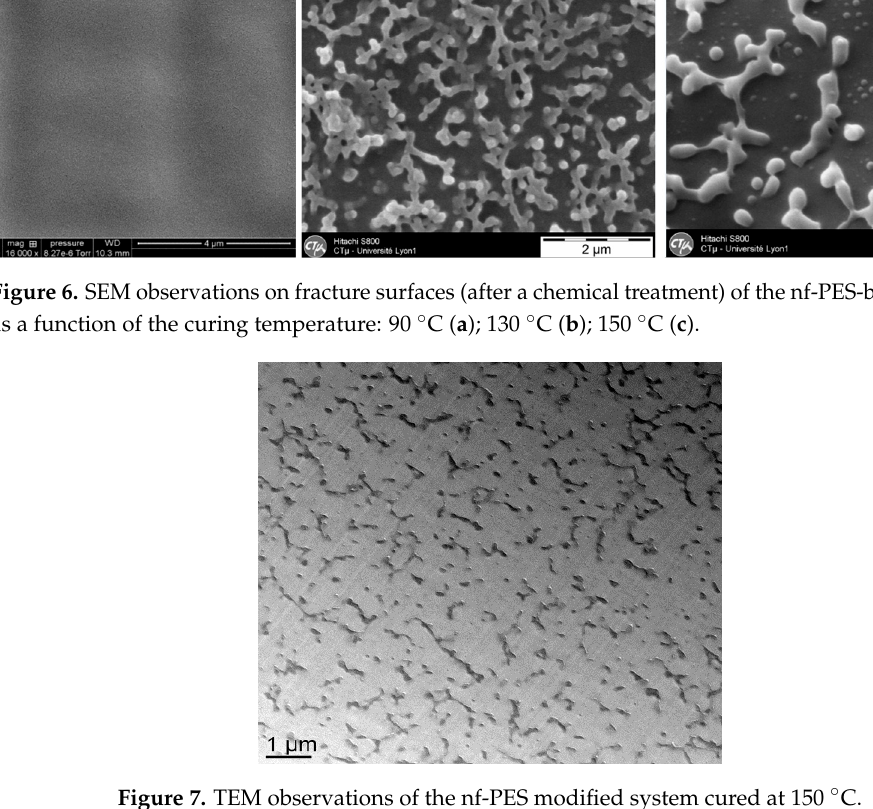
Figure 7. TEM observations of the nf-PES modified system cured at 150 °C.